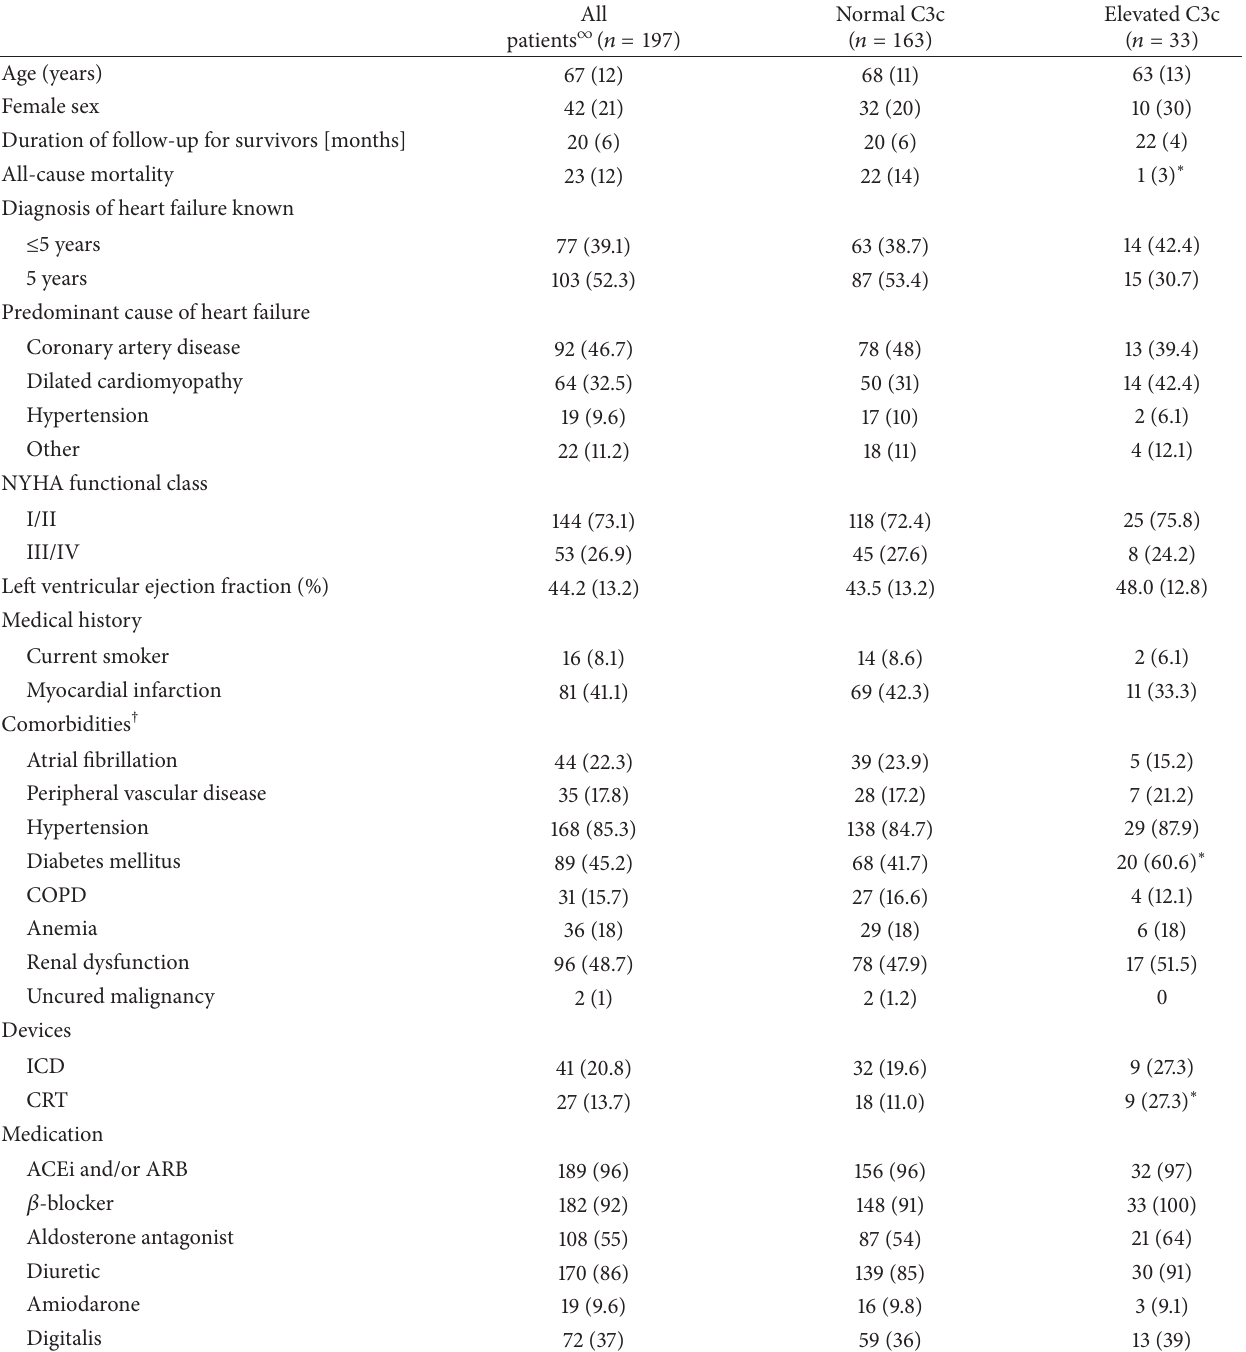
Table 1: Baseline characteristics of study